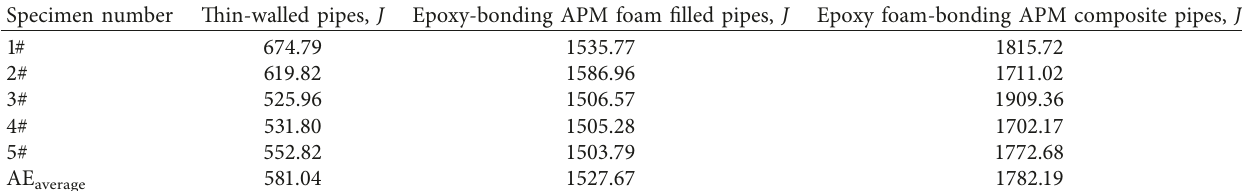
Table 3: Total energy absorption of each specimen.